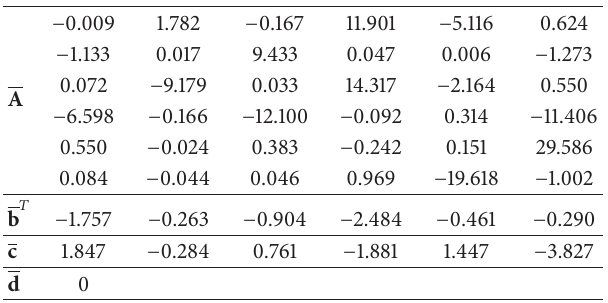
Table 9: Identification result for Case 1 .